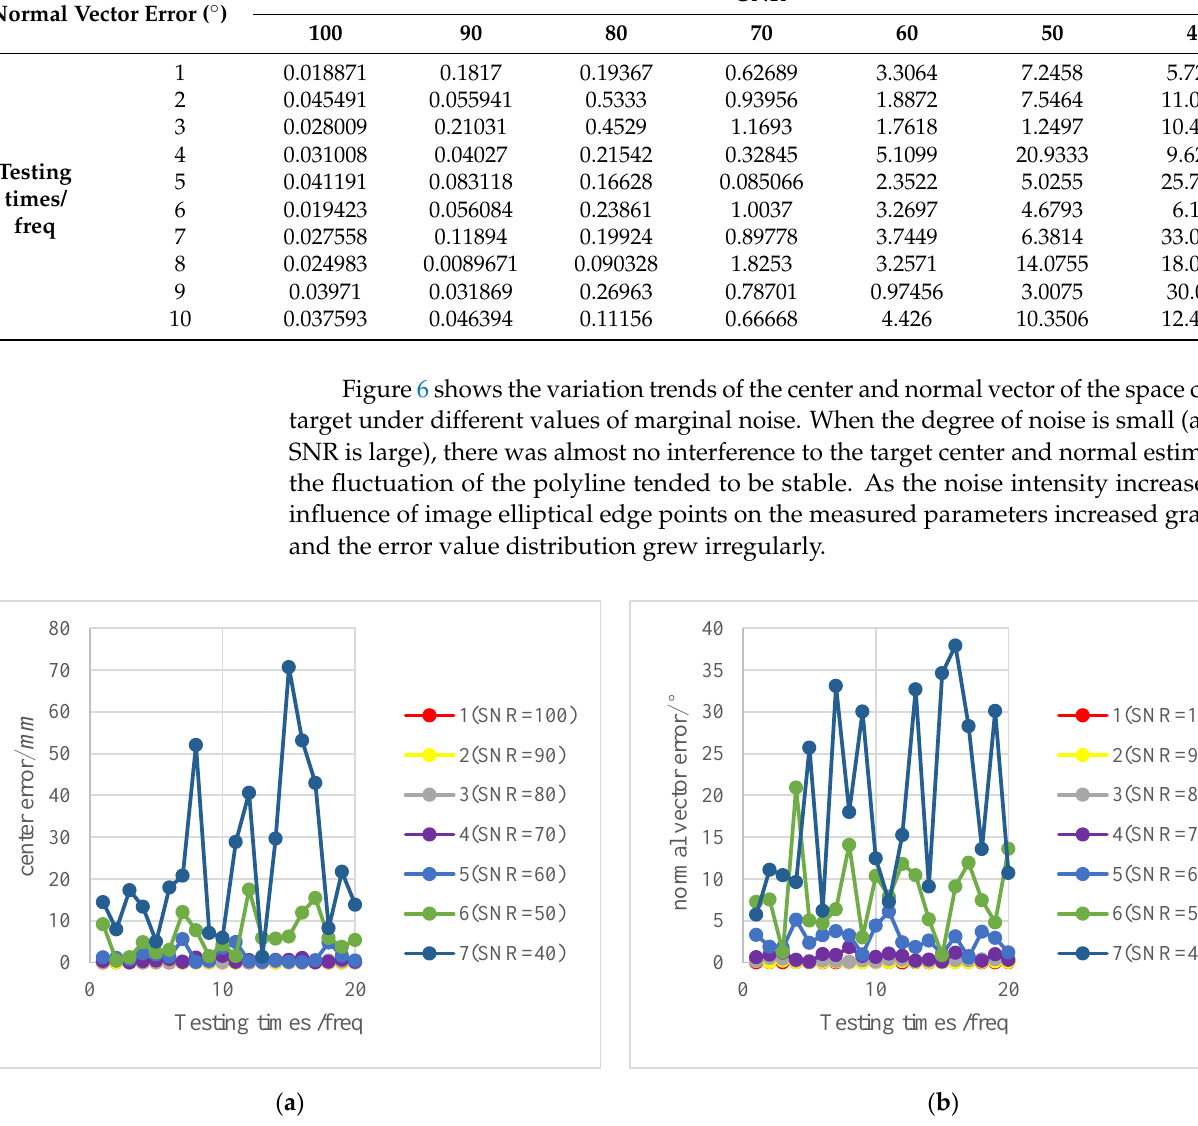
Figure 6. Error results of image elliptical edge points with noise. ( a ) Center error of the space circular target; ( b ) normal vector error of the space circular target.